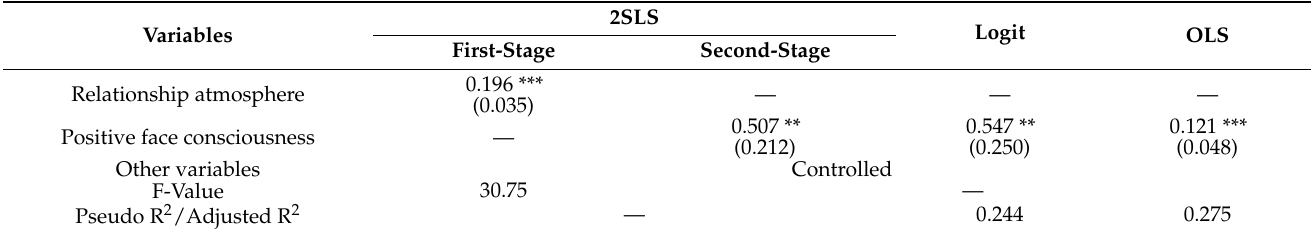
Table 4. The effect of positive face consciousness on farmers’ pesticide safety use.